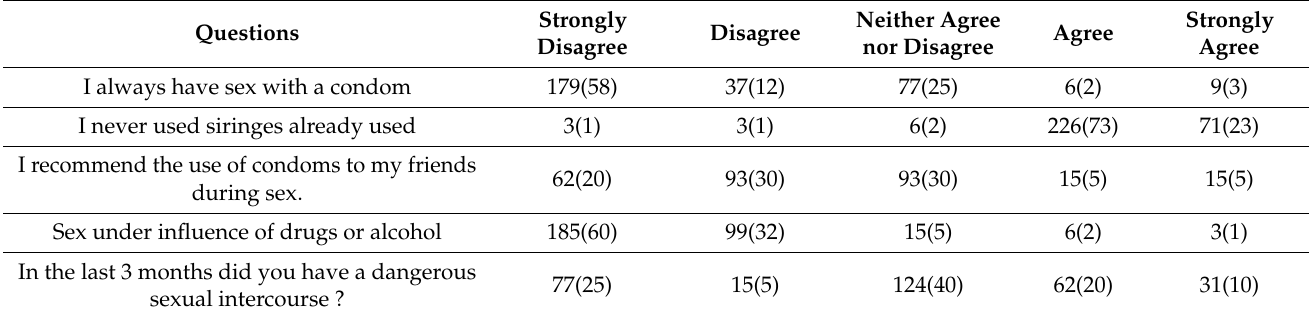
Table 4. HIV and HCV Practices.